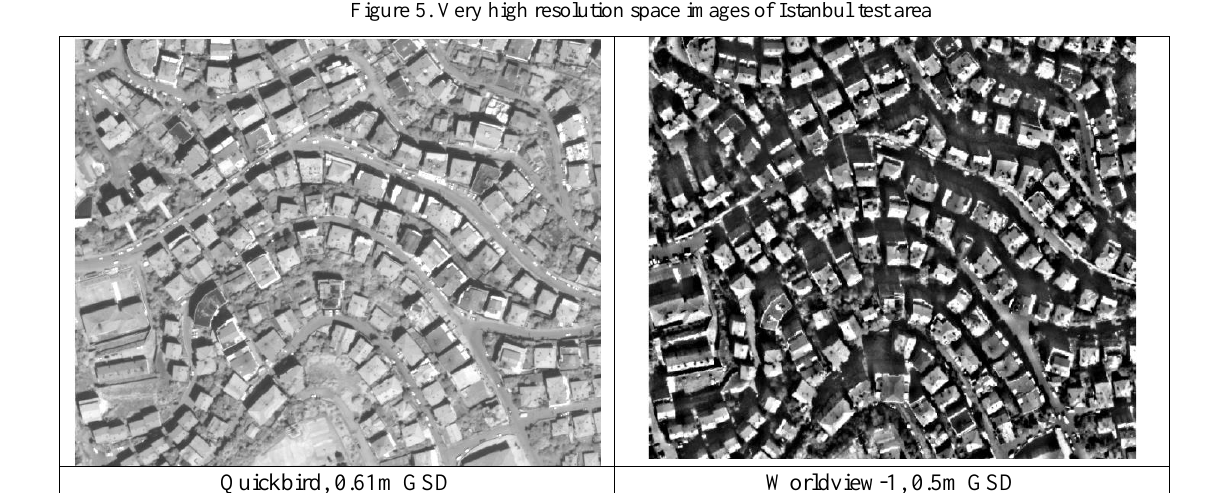
Figure 6. Very high resolution space images of Zonguldak test area